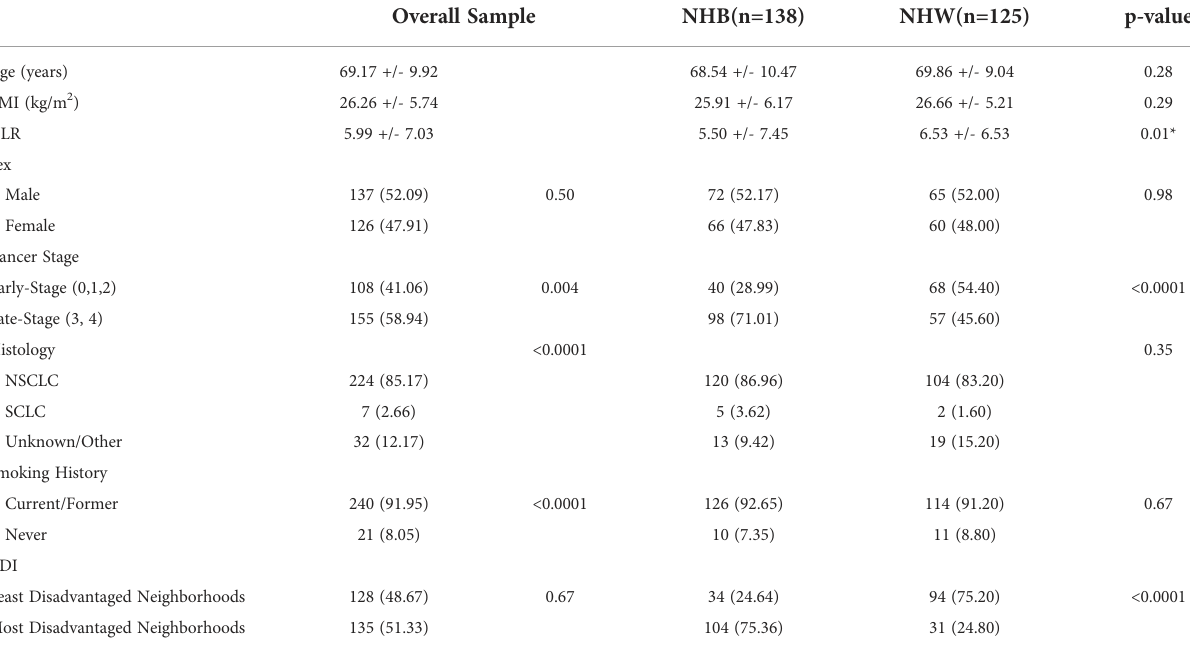
TABLE 1 Demographics, in fl ammatory biomarkers, and neighborhood socioeconomic variables of subjects with lung cancer overall and by race (n=263) 1